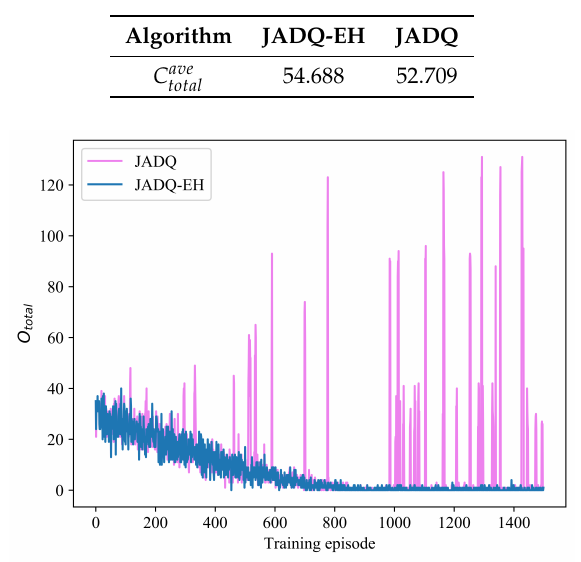
Figure 9. O total comparison of JADQ-EH and JADQ under scenario 1.